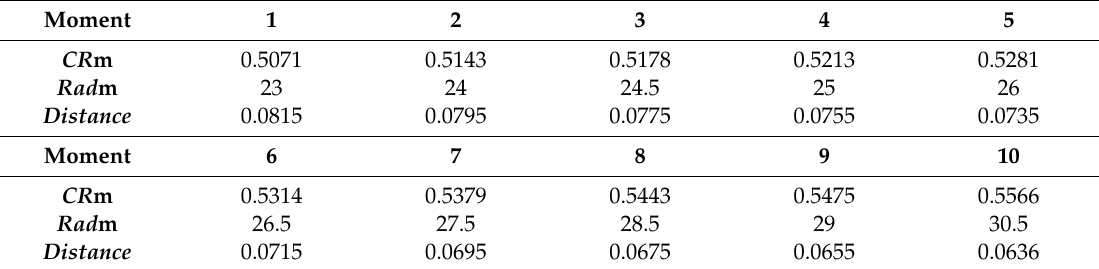
Figure 8. The trajectories of the two encountering ships in a crossing scenario. Table 4. The results calculated by the proposed model in a crossing encountering scenario.